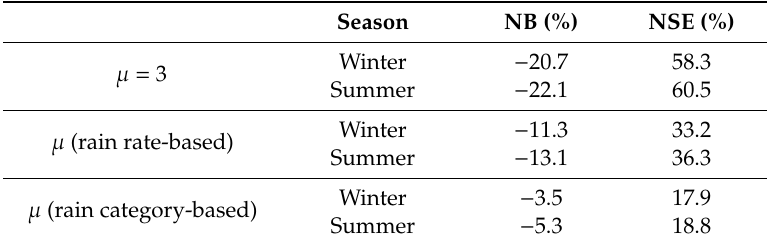
Table 5. Statistical results of the GPM–Parsivel comparison for rain rate given as a constant µ , µ under di ff erent rain rates, as well as µ under di ff erent rain categories. NB and NSE (%) represent normalized bias and normalized standard error,